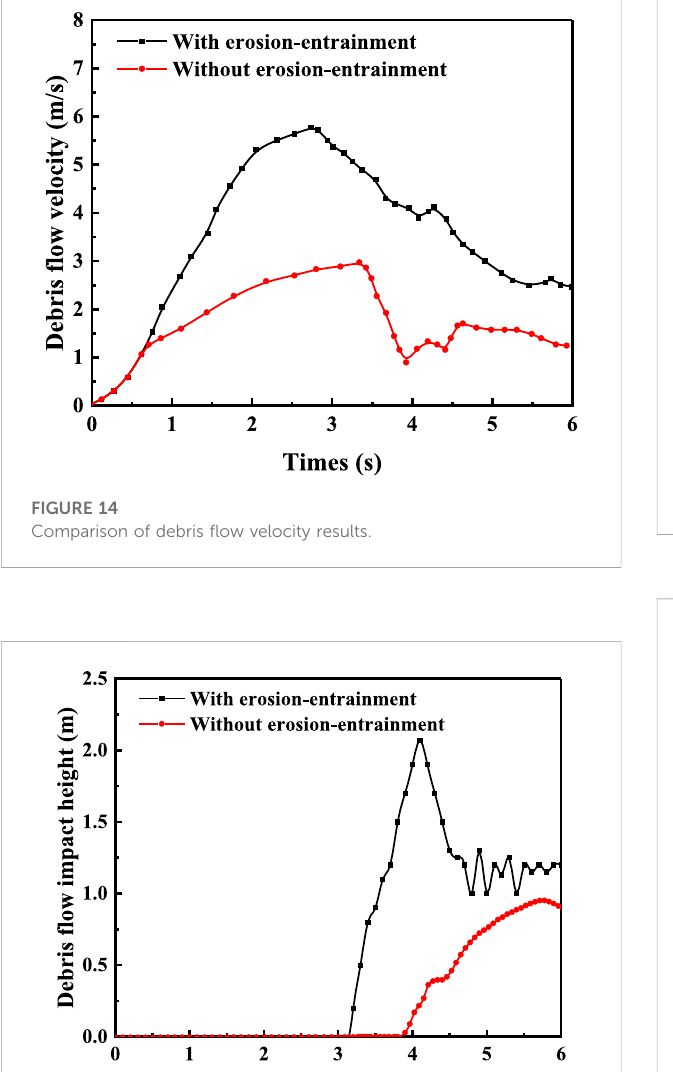
FIGURE 17 Time history results of the